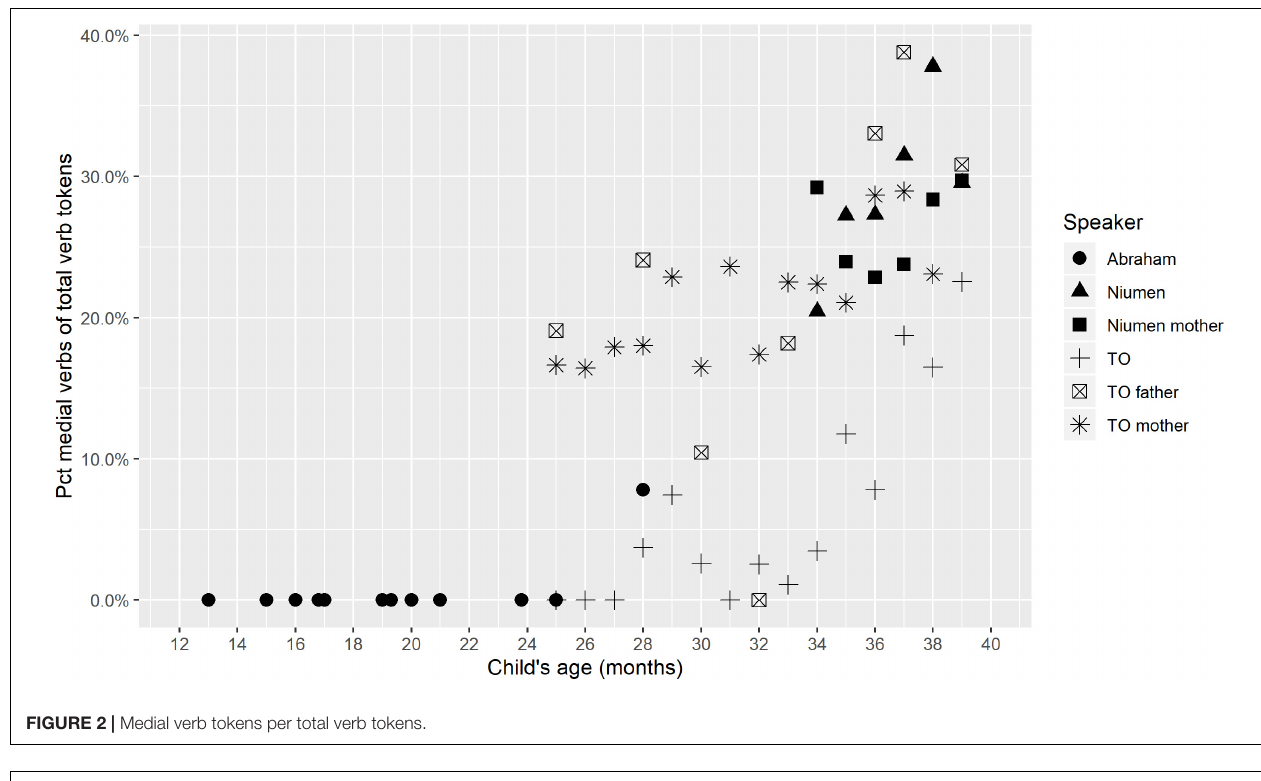
FIGURE 2 | Medial verb tokens per total verb tokens.